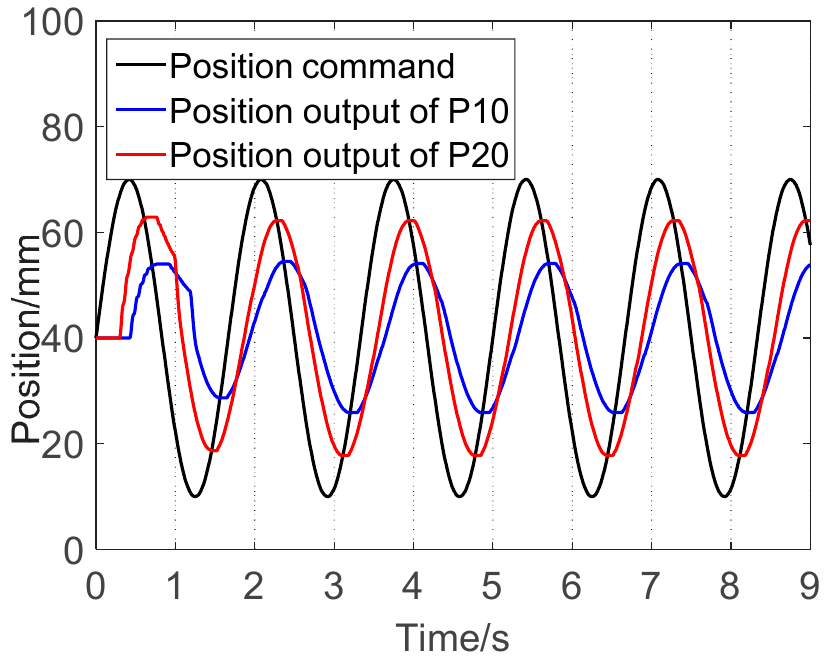
Figure 17. The result of the position in the closed-loop sinusoidal simulation with the different proportional coefficients.